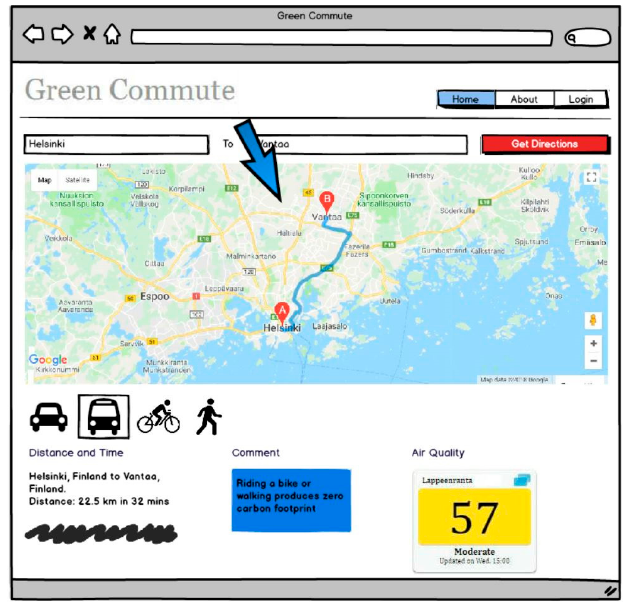
Figure 5. Digital protype of the sustainable smart city service.